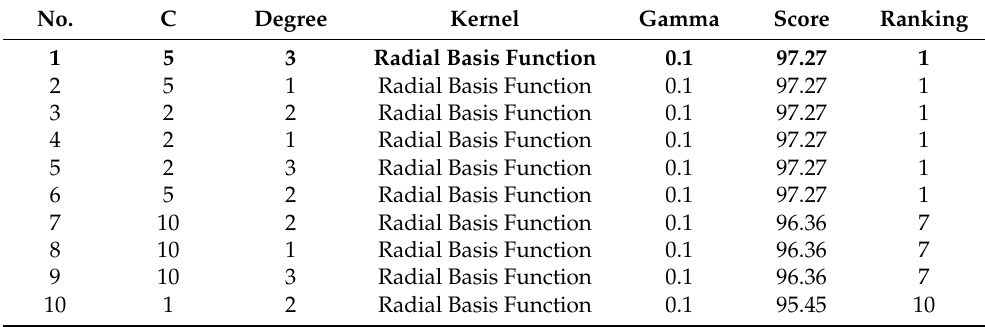
Table 6. Support Vector Machine hyperparameter-tuning results.